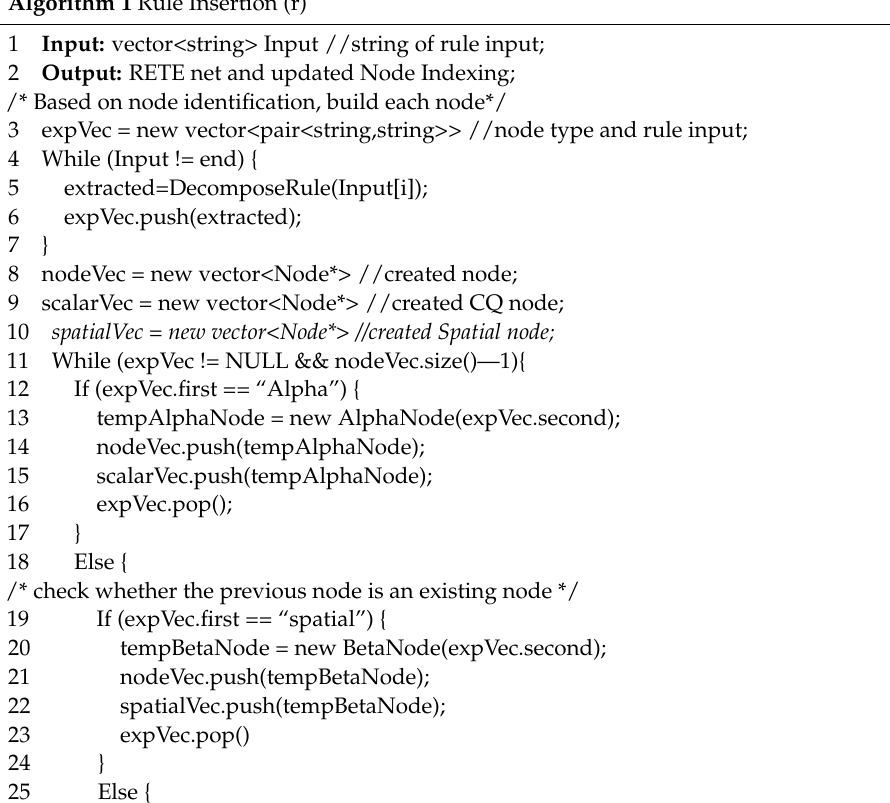
Algorithm 1 Rule Insertion